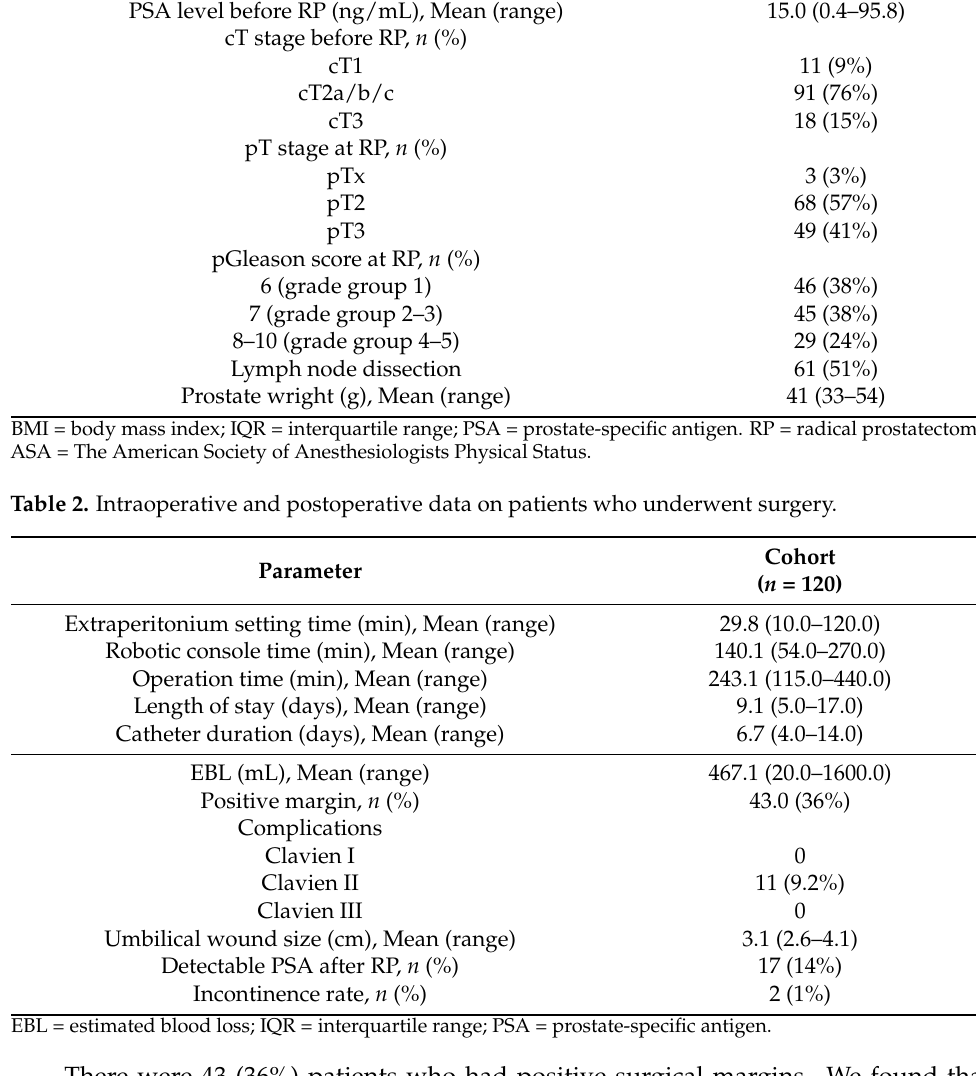
Table 1. Baseline cohort characteristics on patients who underwent surgery. Parameter Age at RP (years), Mean (range)